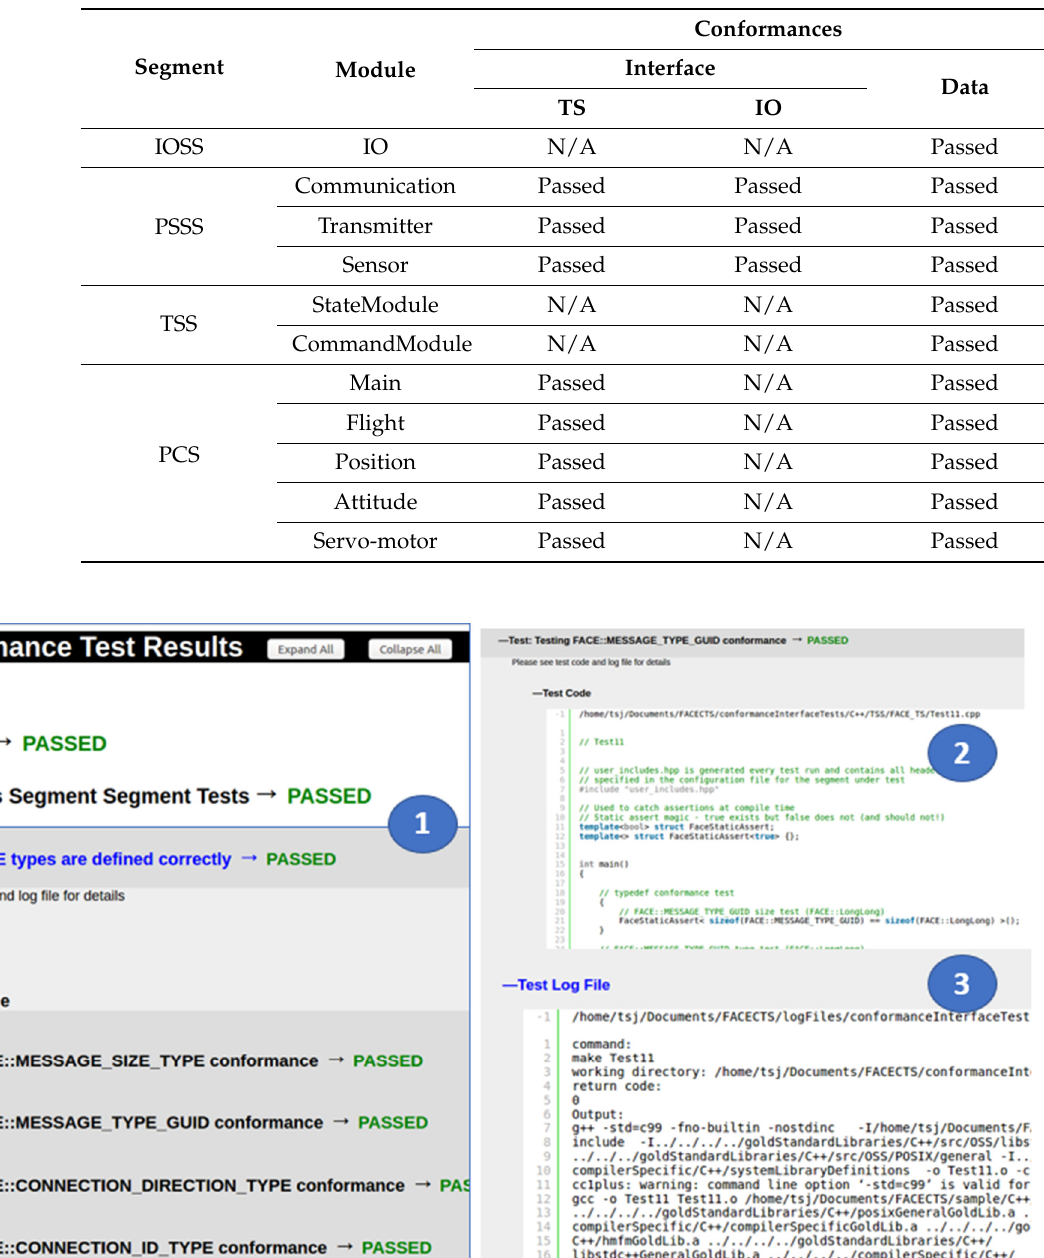
Table 7. A test result of the FACE CTS.